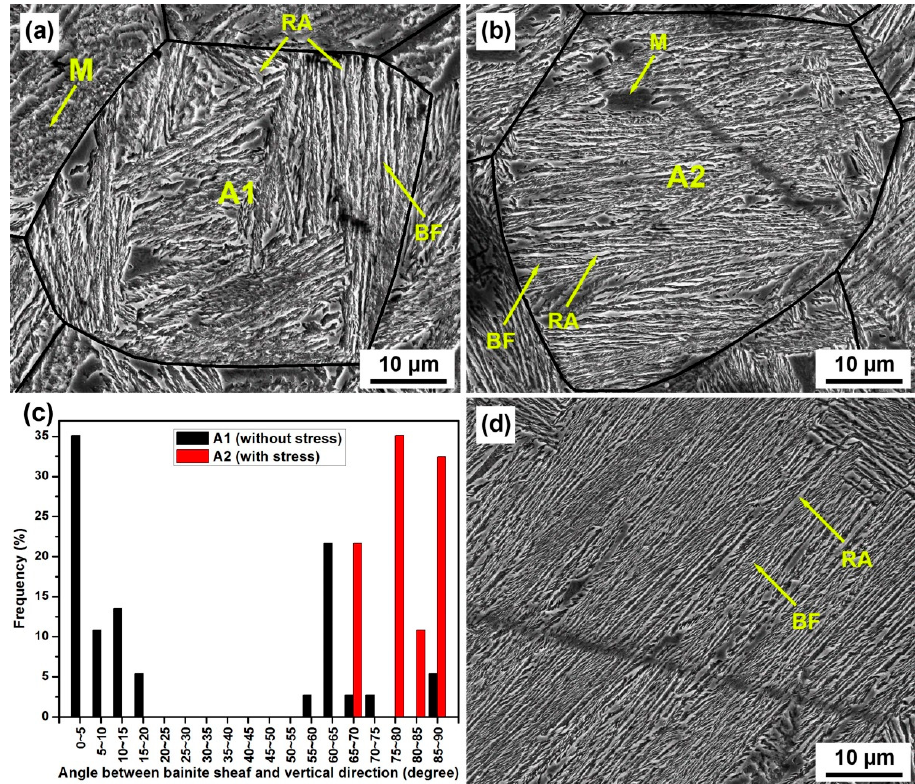
Figure 3. ( a ) Scanning electron microscope (SEM) micrograph of the specimen 1000 ‐ nos (1000 °C, without stress). ( b ) SEM micrograph of the specimen 1000 ‐ stress (1000 °C, with stress). ( c ) Angle between bainite sheaf and vertical direction in austenite grains A1 and A2. ( d ) SEM micrograph of the specimen 1200 ‐ stress (1200 °C, with stress).